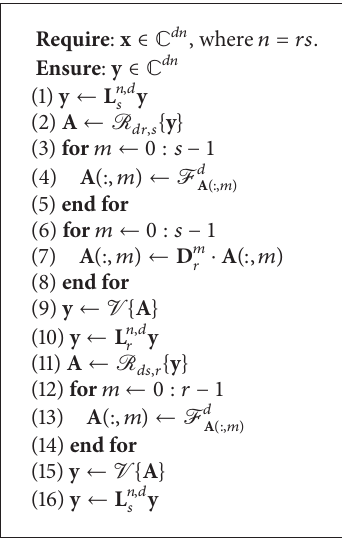
Algorithm 2: Vector-valued DFT (parallel